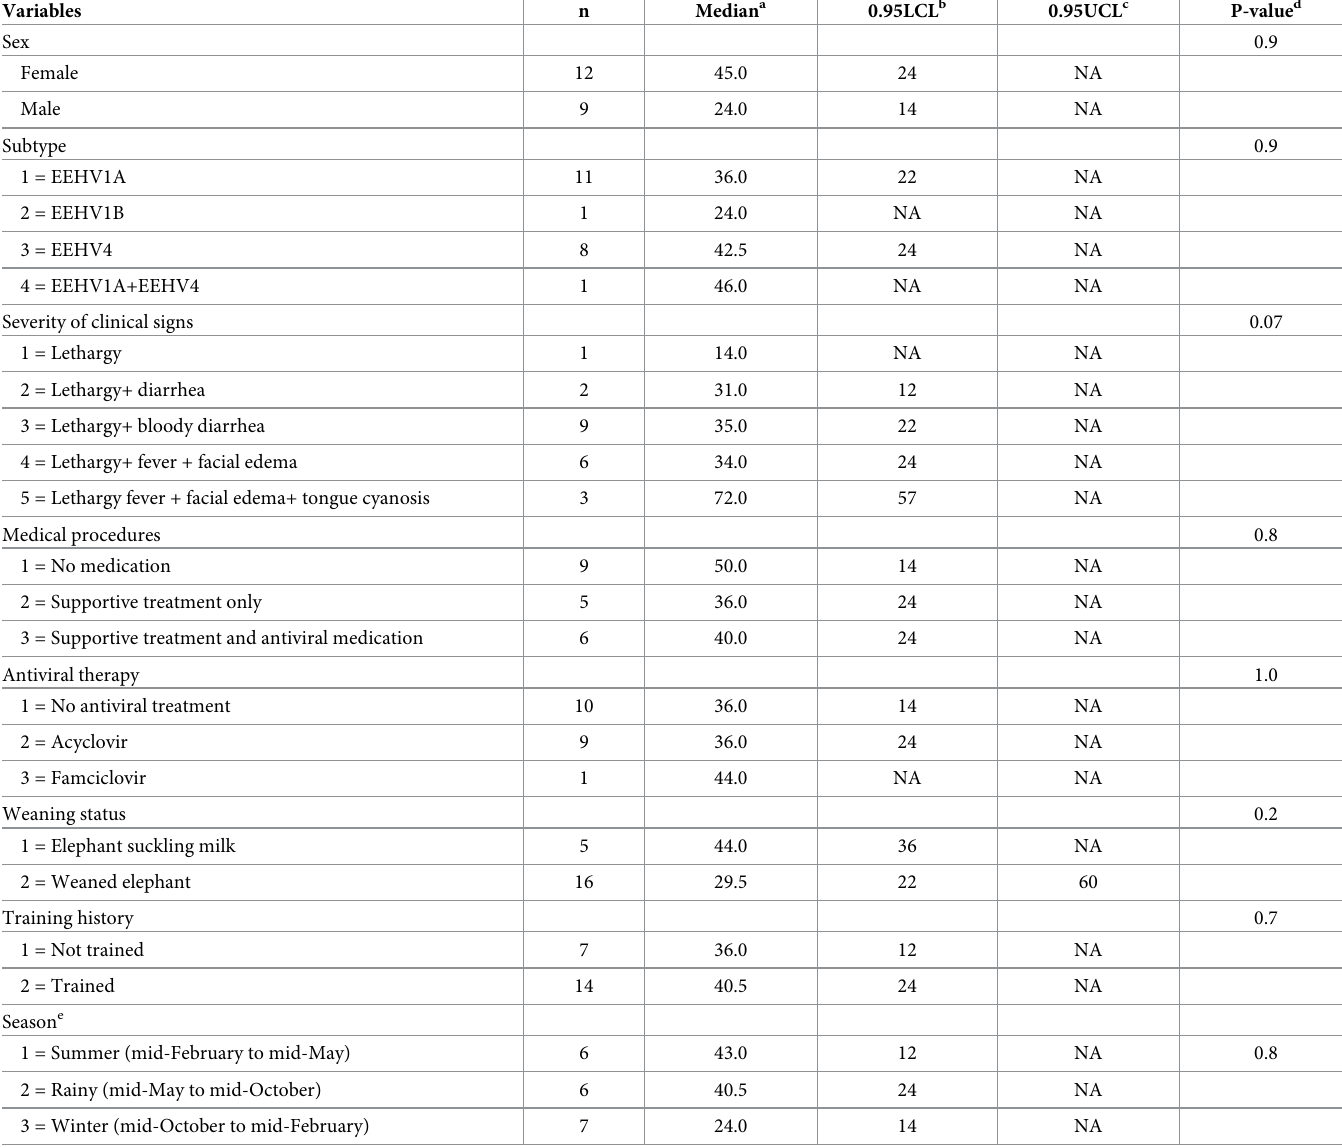
Table 2. Median survival time and univariable analysis. Data are from 21 cases with complete histories from the time of clinical presentation to death.